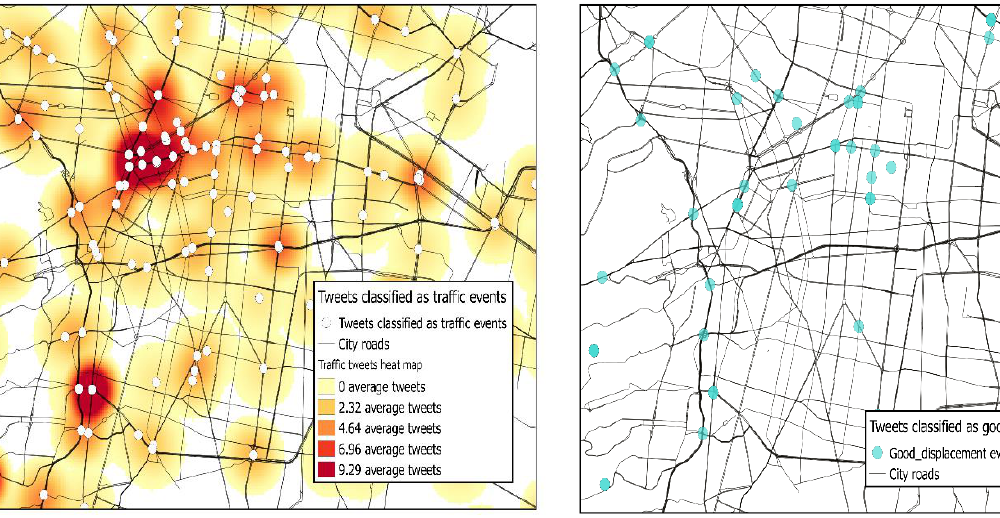
Figure 5. Tweets classified as Good_displacement